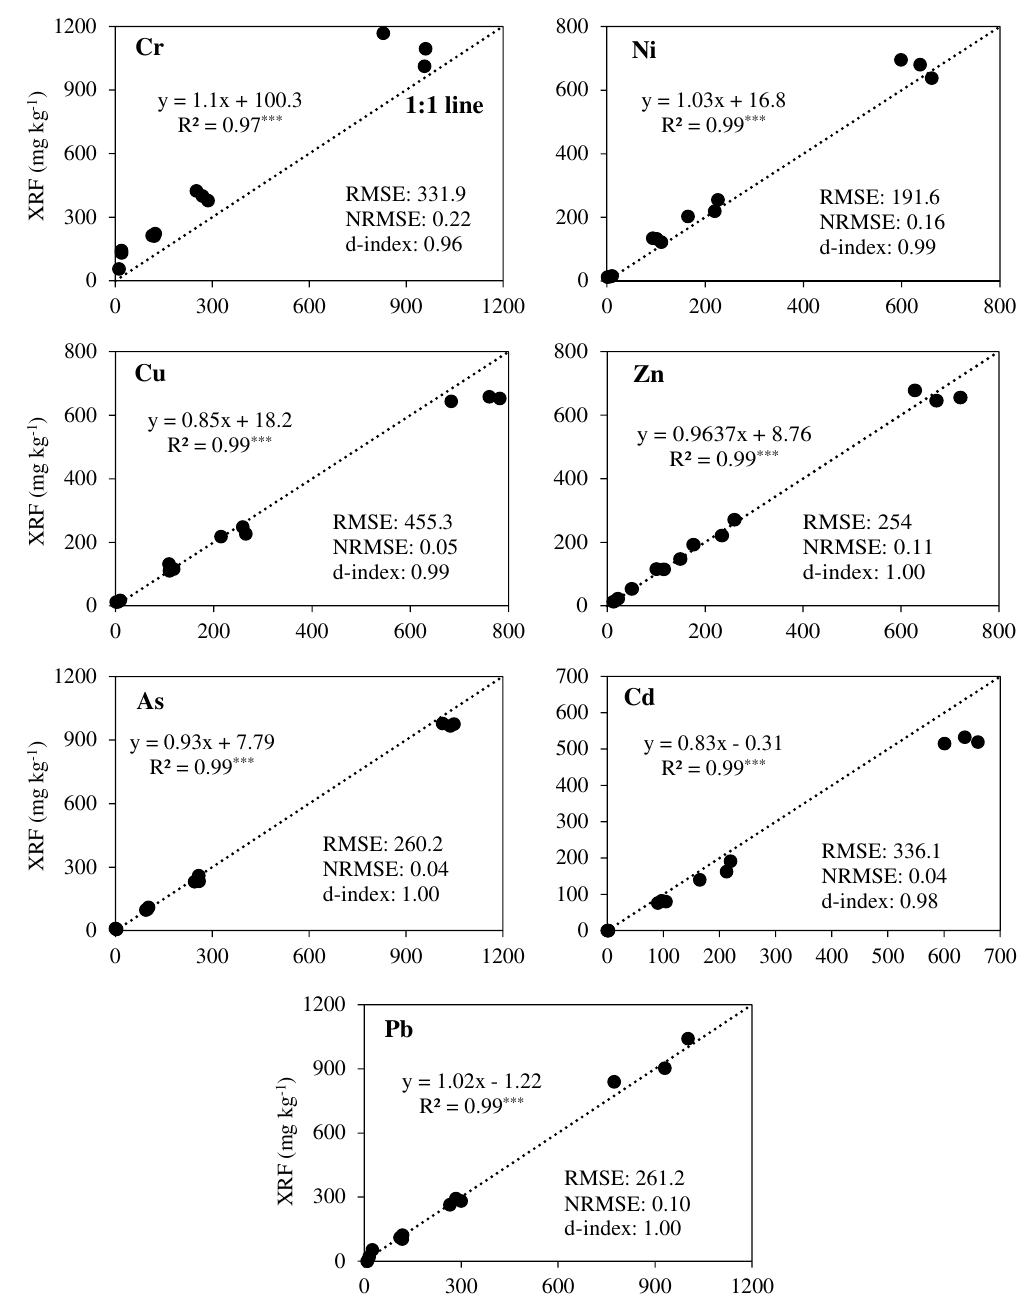
Figure 2. Linear regressions and statistical parameters between metal concentrations obtained with ICP (EPA Method 3050B) and direct measurement by a portable XRF after removing excess water from saturated paste with a pressurized press and oven drying at 105 °C (n = 12). ***: P < 0.001. Dashed lines are 1:1